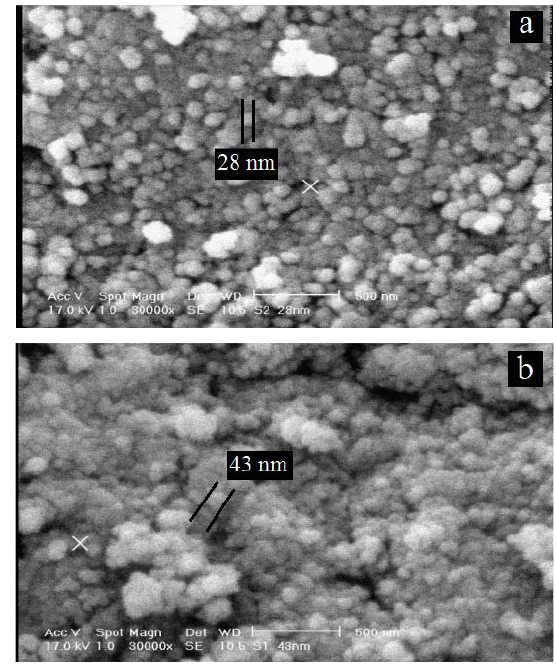
Fig. 4. SEM micrographs of samples (a: CdS-TiO size 28 nm, b: CdS-TiO2-Tyrosine with the average particle size 43